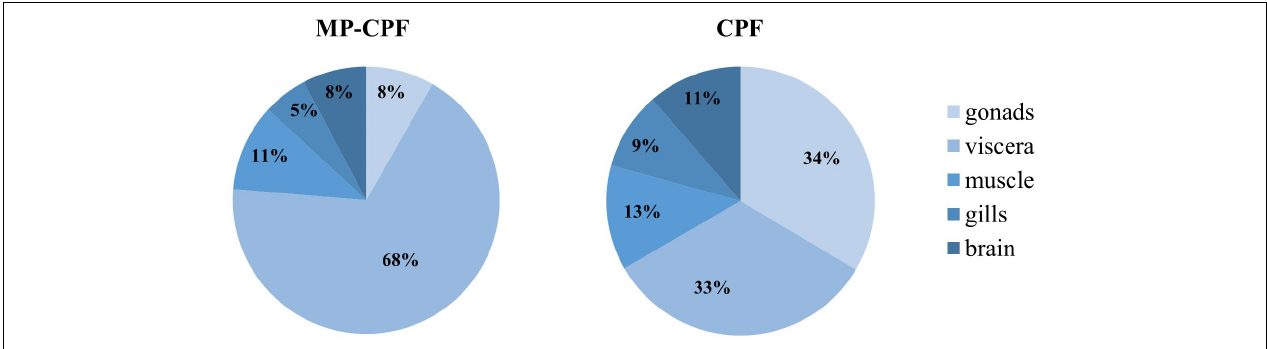
FIGURE 3 | CPF relative distribution in different fish organs, expressed as the percentage of total CPF in fish. CPF was quantified in one fish pool ( n = 3) and two fish pools ( n = 4), for the MP-CPF and CPF groups, respectively.